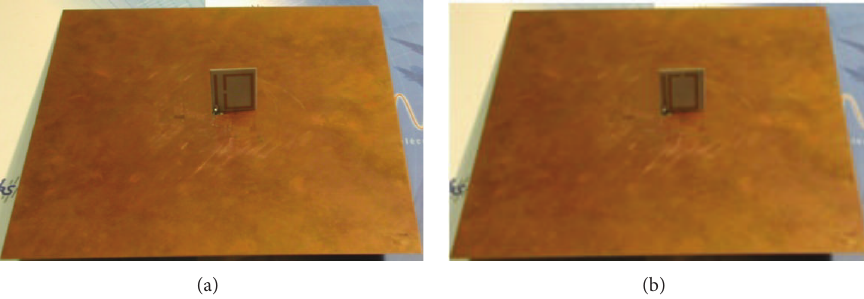
Figure 10: Photos of the realized prototypes for the designed antenna: (a) configuration A1; (b) configuration